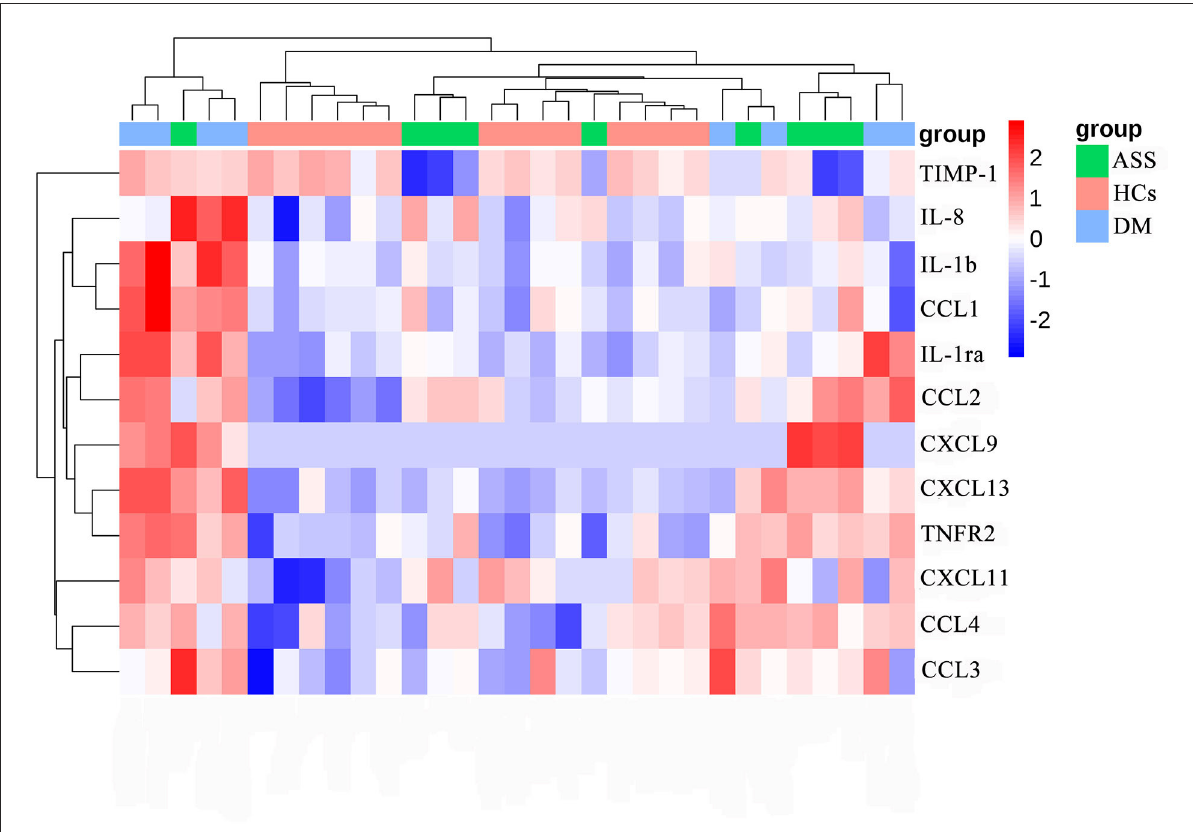
FIGURE2 Heat map of differentially expressed cytokines/chemokines. DM, dermatomyositis; ASS, anti-synthetase syndrome; HCs, healthy